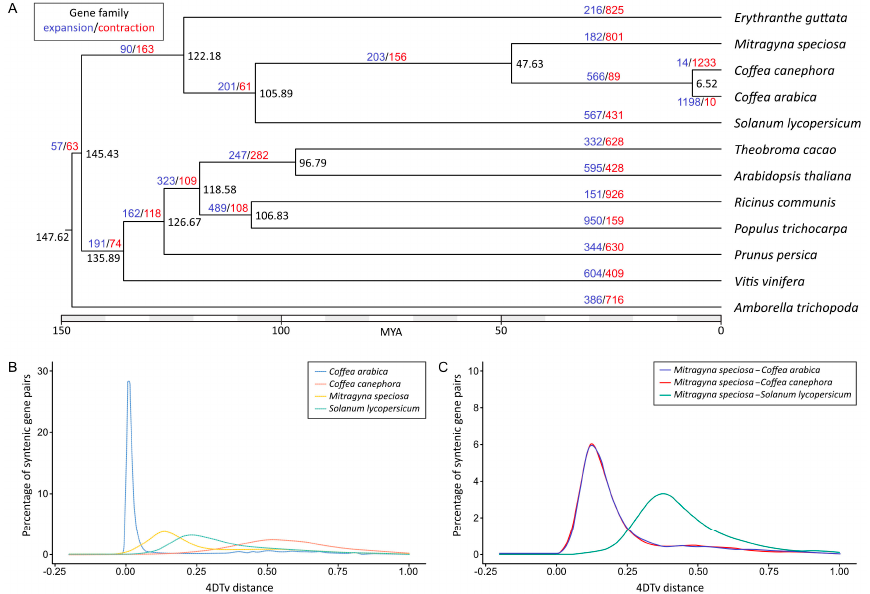
Figure 3. Comparative genomics of M. speciosa and related species. ( A ) A maximum-likelihood tree of M. speciosa , two Coffea species, and nine other plant species constructed based on single-copy orthol- ogous protein sequences. Numbers at each node represent the estimated divergence time in million years ago (MYA). Numbers in blue and red represent the numbers of gene families that have ex- panded or contracted, respectively, relative to their ancestors. ( B ) The distribution of fourfold syn- onymous third-codon transversion position (4DTv) distances between paralogous genes in M. speci- osa , C. arabica , C. canephora , and S. lycopersicum . ( C ) The distribution of 4DTv distances between orthologous genes in M. speciosa and C. arabica , C. canephora and S. lycopersicum . Peaks of intraspecific and interspecific 4DTv distributions indicate whole-genome duplication and speciation events, re- spectively.